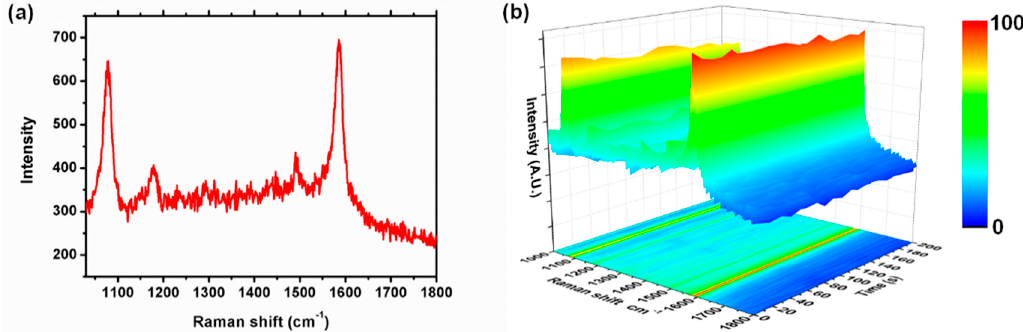
Figure 3. ( a ) Surface enhanced Raman scattering (SERS) spectrum of 10 − 4 mol/L PATP molecules measured with 40 s of laser irradiating on the Pt-based hollow nanostructure substrate. ( b ) Time-dependent SERS spectra of 10 − 4 mol/L PATP on the Pt-based hollow nanostructure substrate illuminated with the laser power of 0.3 mW.